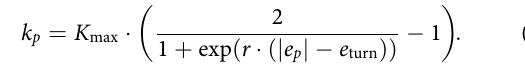
( Figure 3 ). The tangential error ( e t ) is the projection of the error ( e ) between the actual ( x ) and desired position ( x d ) on the tra- jectory tangent through the desired position. The perpendicular error ( e p ) is the projection of the error ( e ) on the normal plane ( N ) defined by the tangent and actual